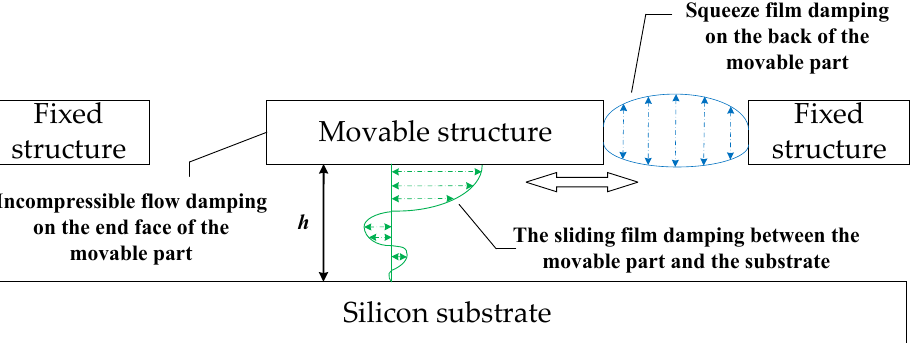
Figure 3. Side view of viscous damping distribution of microresonator.